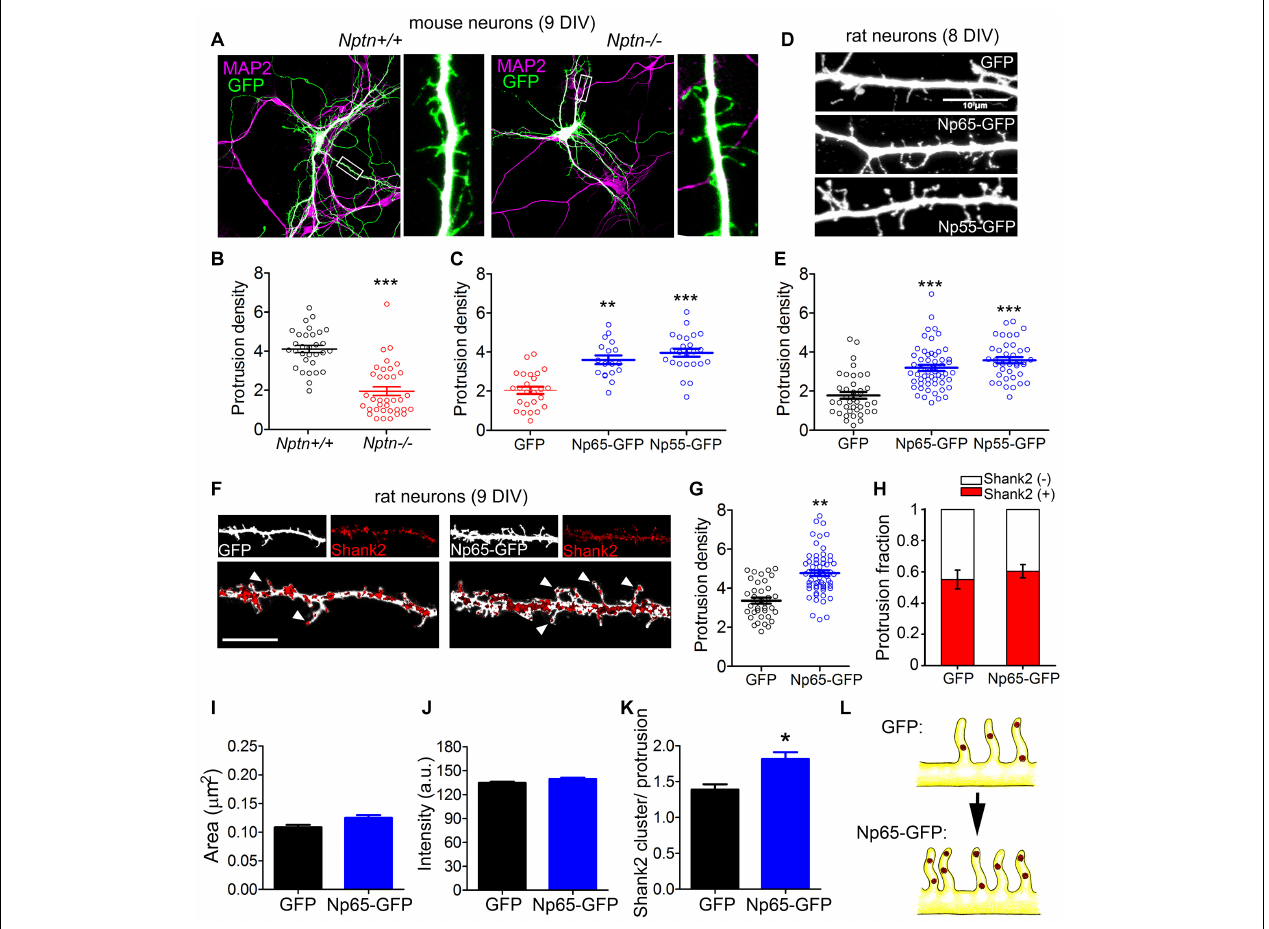
FIGURE 3 | Neuroplastin promotes formation of dendritic protrusions. (A–C) Reduced number of dendritic protrusions in Nptn − / − compared to Nptn + / + mouse primary hippocampal neurons at 9 DIV. (A) Nptn − / − and Nptn + / + neurons transfected with GFP-encoding plasmids at 6–7 DIV using Lipofectamine. At 9 DIV, neurons were fixed and stained with anti-GFP antibody followed by an Alexa 488-conjugated antibody to enhance their intrinsic fluorescence (green) and with anti-MAP2 antibodies followed by a proper secondary antibody to detect dendrites (magenta). Images were obtained using a confocal microscope. Scale bar = 100 µ m. (B) Protrusion density (number of dendritic protrusions per 10 µ m) of GFP-filled Nptn − / − and Nptn + / + neurons (circles) is expressed as mean ± SEM from three independent cultures. *** p < 0.001 between genotypes using Student‘s t -test ( Nptn + / + GFP = 4.12 ± 0.18, n = 33; Nptn − / − GFP = 1.72 ± 0.19, n = 36). (C) Protrusion density of GFP-, Np65- GFP-, or Np55-GFP-expressing Nptn − / − neurons from two independent cultures. *** p < 0.001 or ** p < 0.01 vs. Nptn − / − GFP using Student‘s t-test ( Nptn − / − GFP = 1.92 ± 0.22, n = 26; Nptn − / − Np65-GFP = 3.67 ± 0.18, n = 20; Nptn − / − Np55-GFP = 3.77 ± 0.19, n = 26). (D,E) Both neuroplastin isoforms increase dendritic protrusion density in rat neurons at 8 DIV. (D) Confocal images show rat neurons transfected with plasmids encoding GFP, Np65-GFP or Np55-GFP at 7 DIV. At 8 DIV, neurons were fixed and stained with anti-GFP antibody followed by an Alexa 488-conjugated antibody (white). Scale bar = 10 µ m (E) Protrusion densities of 40–50 neurons per group (circles) from 3 to 4 independent cultures. *** p < 0.001 vs. GFP transfected cells using Student‘s t -test (GFP = 1.95 ± 0.19, n = 39; Np65-GFP = 3.23 ± 0.14, n = 56; Np55-GFP = 3.58 ± 0.16, n = 38). (F–H) Overexpression of Np65-GFP increases the number of newly formed Shank2-containing dendritic protrusions. (F) Cropped confocal images of dendritic segments of rat neurons transfected with GFP or Np65-GFP at 7 DIV. At 9 DIV, neurons were fixed and stained with primary antibodies against GFP (white) and Shank2 (red). Arrow heads point to Shank2 spots in dendritic protrusions. Scale bar = 10 µ m. (G) Protrusion density (GFP = 3.151 ± 0.182, n = 48; Np65-GFP = 4.642 ± 0.145, n = 54) and (H) Distribution of Shank2-positive and Shank2-negative protrusions were calculated as a fraction from n = 40–50 neurons per group from N = 3 independent experiments. Plots display mean ± SEM as indicated. ** p < 0.01 for Np65-GFP vs. GFP using Student‘s t -test [Shank2(+): GFP = 0.54 ± 0.07; Np65-GFP = 0.60 ± 0.06]. (I–K) (I) Size of puncta (area; GFP = 0.10 ± 0.01, n = 747; Np65-GFP = 0.11 ± 0.01, n = 738), (J ) Fluorescence intensity (GFP = 127.6 ± 2.1; Np65-GFP = 131.5 ± 1.9) and (K) Number of Shank2 clusters/protrusion in neurons (GFP = 1.46 ± 0.17, n = 43; Np65-GFP = 1.91 ± 0.18, n = 49) of the experiments displayed in (F) . * p < 0.05 between Np65-GFP-expressing and GFP-expressing neurons using Student‘s t -test. (L) The upper sketch on the left illustrates dendritic protrusions enriched on Shank2 in control GFP-filled hippocampal neurons at 9 DIV. Np65-GFP-expressing neurons (lower sketch) display more spinogenic protrusions with Shank2